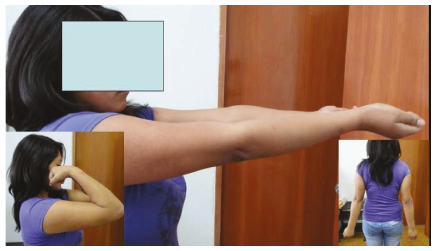
Figure 5: Case 2. Final elbow range of